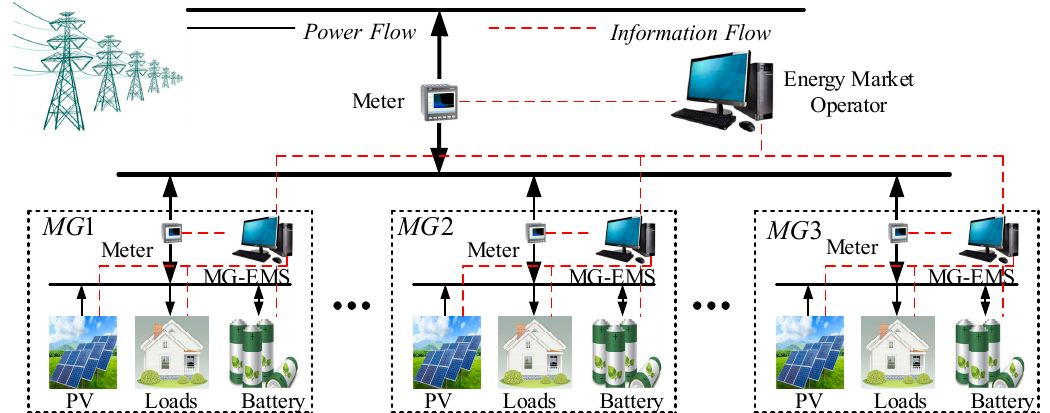
Figure 1. Structure of an MMG (multiple microgrid).